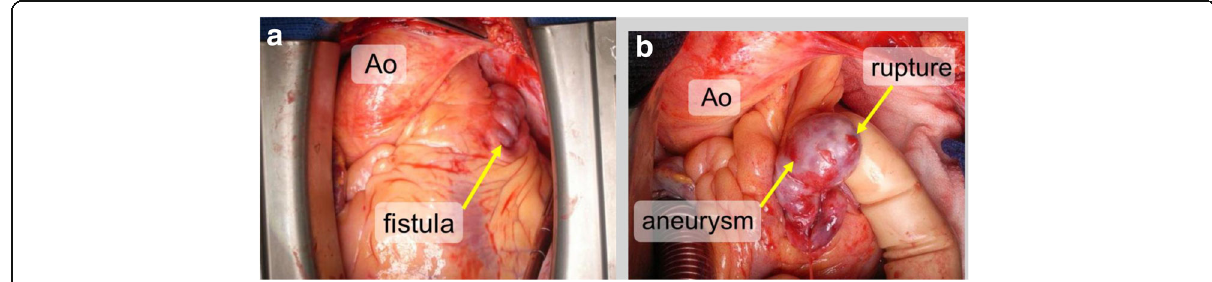
Fig. 2 Macroscopic findings. The intraoperative macroscopic findings revealed coronary artery fistulae in front of the left atrial appendage and on the pulmonary artery root, accompanied by a 15-mm saccular-type coronary artery aneurysm ( a ). The top of the aneurysm had a papillary protrusion that ruptured ( b